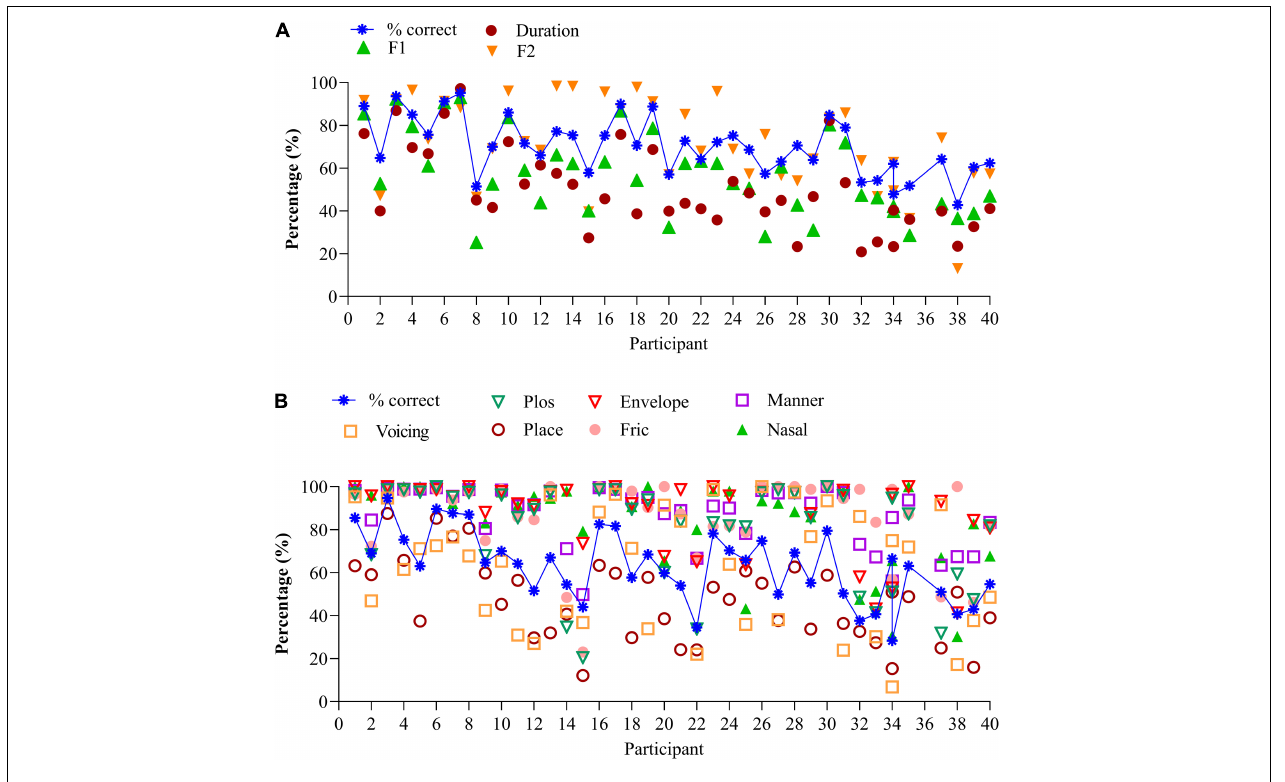
FIGURE 2 | (A) Vowel identification for the 40 participants, together with the speech features. Data are ranked according to increasing (poorer) SiN scores. (B) Consonant identification for the 40 participants, together with the speech features. Data are ranked according to increasing (poorer) SiN